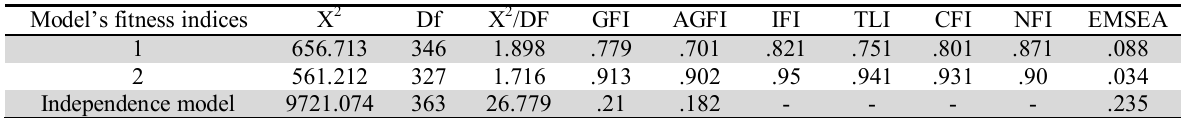
Fitness indices for models